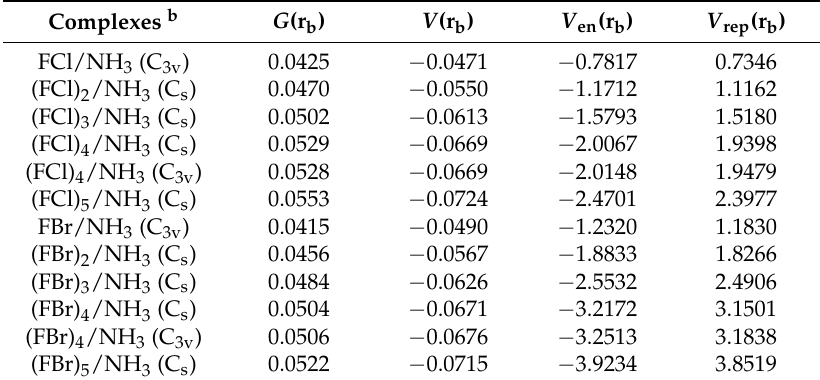
Table 2. Local kinetic energy density and potential energy density and its components at the intermolecular X ··· N BCP. a Complexes